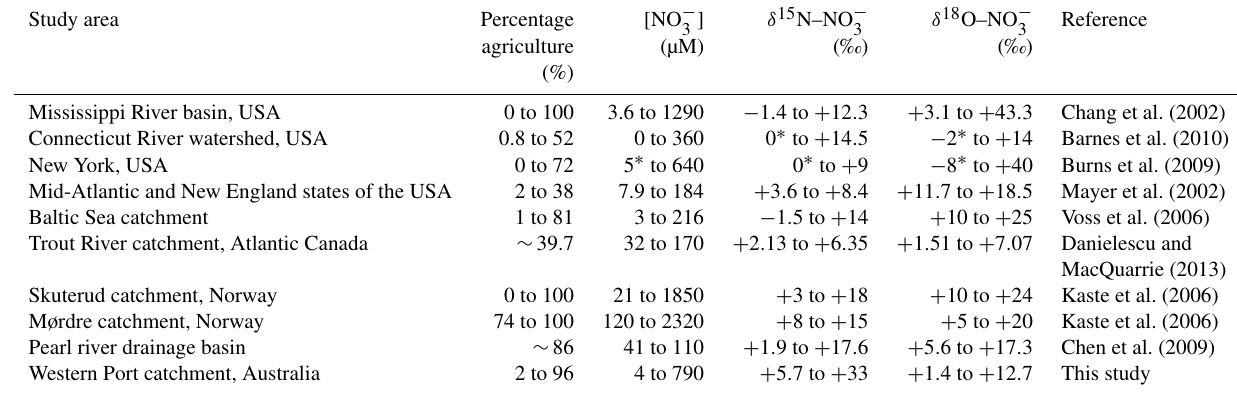
Table 2. Comparison of NO − concentrations and isotopes across different systems reported in the literature. 3